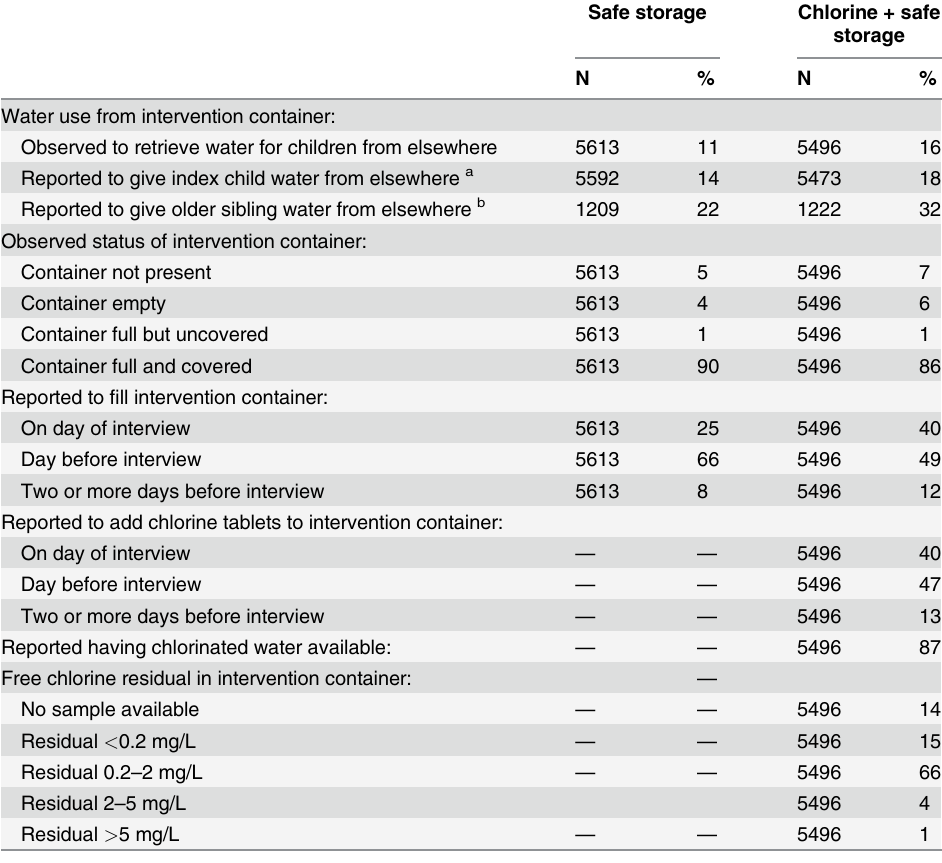
Table 2. Uptake indicators in intervention groups (cumulative data from 10 follow-up visits).